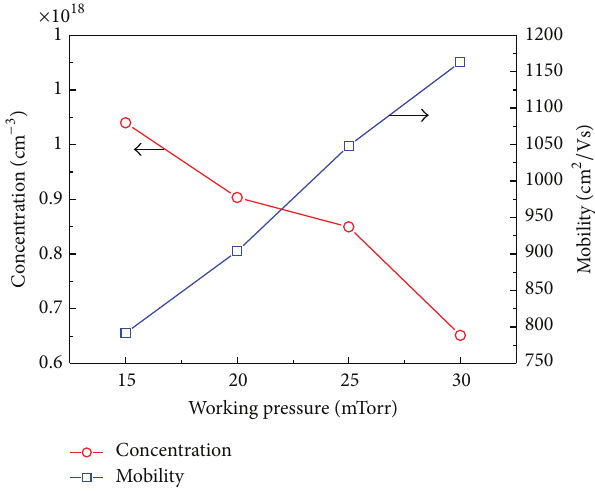
Figure 10: Concentration and mobility measured by Hall measure- ment as a function of working